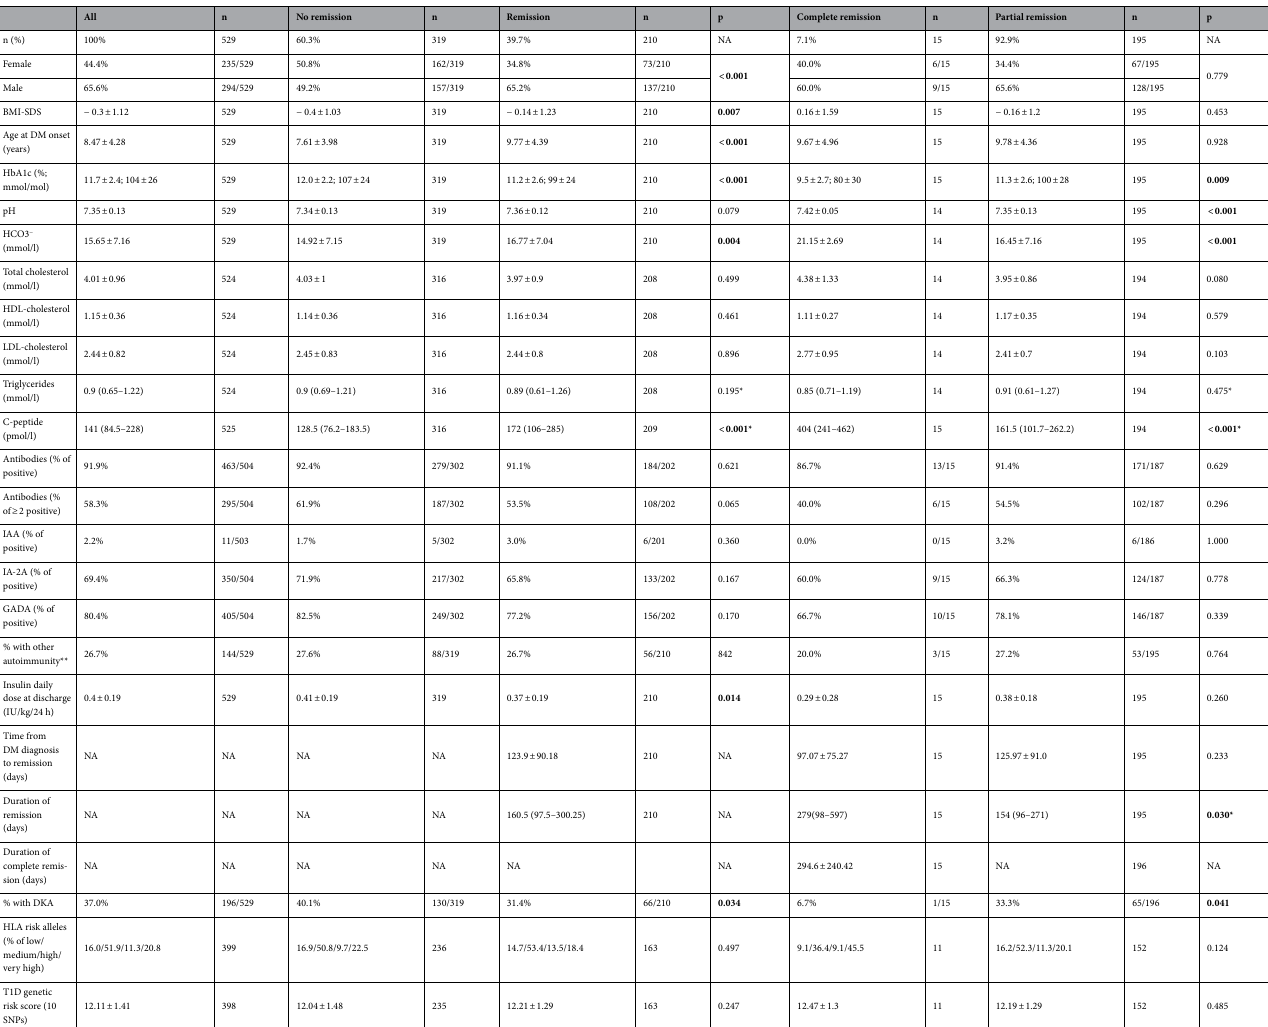
Table 1. Basic characterization of the cohort and comparison between remitters and non-remitters, and partial and complete remitters. HLA risk alleles for T1D were evaluated as DR3/DR4- very high risk, DR4/ DR4 or DR3/- high risk, one DR3 or DR4 allele—medium risk, and none of the risk alleles—low genetic risk for T1D. Metric data are expressed as mean ± SD (normally distributed data) or as median and interquartile range, 25th–75th percentiles (skewed data). BMI body mass index, SDS standard deviation score, DKA diabetic ketoacidosis, NA not applicable, IAA autoantibodies against insulin, IA-2A autoantibodies against tyrosine phosphatase, GADA autoantibodies against glutamic acid decarboxylase. Significant values are given in bold. Differences between two groups were tested using t-test for metric data (*Calculated with log transformed data) and by Fisher’s test for binary data. **Among non-remitters had 40 celiac disease, 45 Hashimoto disease, and 3 had both celiac and Hashimoto; in remitters 17 had celiac disease, 34 Hashimoto disease, 1 autoimmune hemolytic anemia, 3 both celiac and Hashimoto, and 1 had Hashimoto and nephrotic syndrome, and in the subgroup of complete remitters 1 had Hashimoto disease, 1 autoimmune hemolytic anemia, and 1 had Hashimoto and nephrotic syndrome. The standard deviation score (SDS) for BMI and height was calculated using local reference values 15